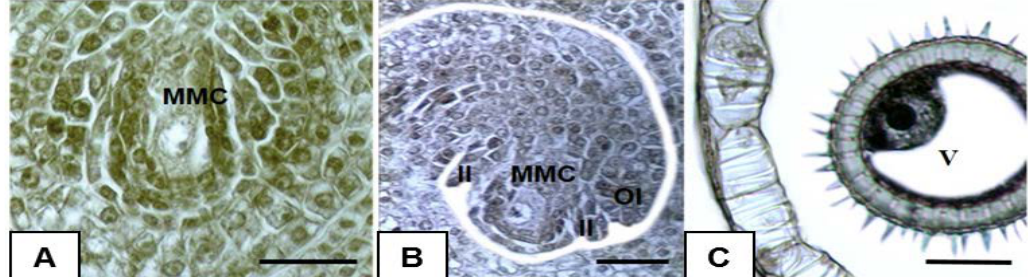
Fig. 6. Stage 9: Megaspore mother cell differentiation. A. Megaspore mother cell. B. Integuments initiation. C. Vacuolated pollen grain. II: Inner integument, MMC: Megaspore mother cell, OI: Outher integument, V: Vacuole. Bar: 5µm (A-C)